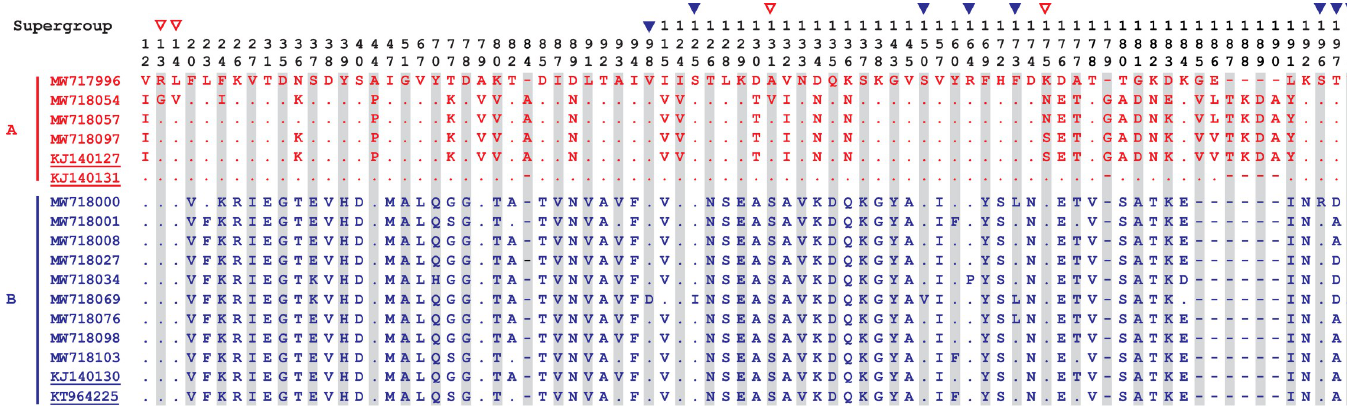
Fig 5. Alignment of partial-length of Wolbachia wsp gene deduced amino acid (~200 AA) sequences identified in this study (MW717996, MW718054, MW718057, MW718097, MW718000, MW718001, MW718008, MW718027, MW718034, MW718069, MW718076, MW718098, MW718103) together with 4 mostly identical reference sequences (KJ140127, KJ140131, KJ140130 and KT964225) obtained in GenBank database. Strains belonging to supergroup A and B are shown in red and blue, respectively, while the reference sequences are indicated with underlines. Numbers, read from top to bottom, above the sequences are deduced amino acid positions on the wsp gene of MW717996. Dots indicate nucleotides identical to the reference sequences. The triangles above nucleotide position numbers indicate sites of mutations in our isolates (supergroup A: 5 in red, and supergroup B: ▼ in blue) relative to the one or both of the reference sequences.